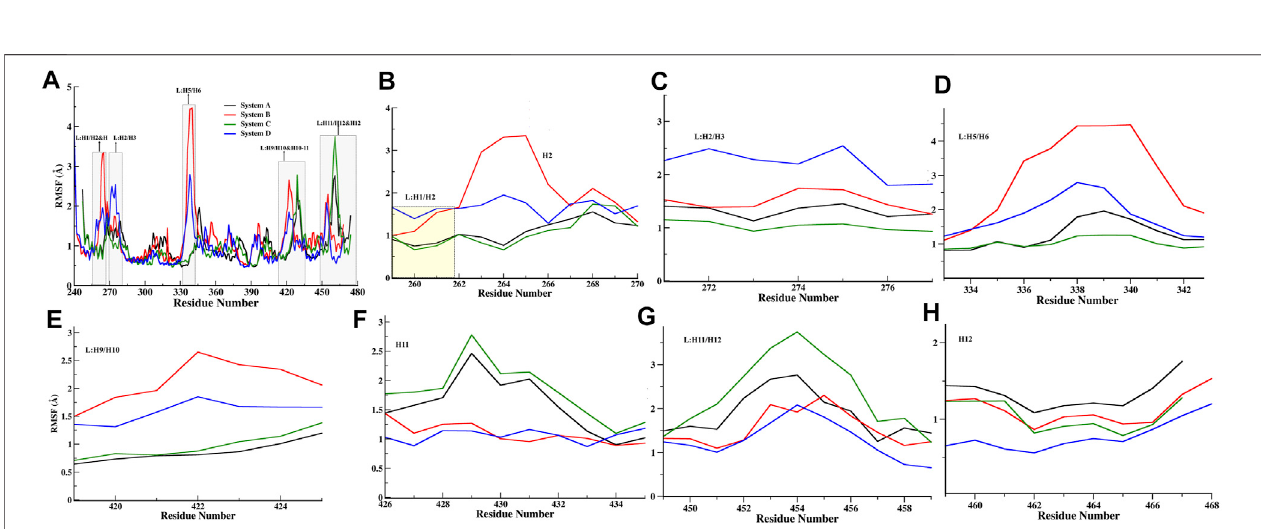
FIGURE3| Quantitativeanalysisof fl uctuationfromtheMDsimulation. (A) RMSFofC α atomsofallFXRSystems.Thevalueswerepresentedduringthe500nsMD simulations time (ns) scale. The different regions of fl uctuations observed in the RMSF plot are mentioned. The region-wise RMSF plots wereshown in (B) for loop L:H1/ H2andhelixH2region, (C) loopbetweenhelices2and3regions(L:H2/H3), (D) LoopbetweenhelicesH5andH6region(L:H5/H6), (E) loopbetweenH9andH10(L:H9/ H10), (F) helix H11, (G) loop between helix 11 and 12 (L:H11/H12) region, and (H) helix H12 regions.